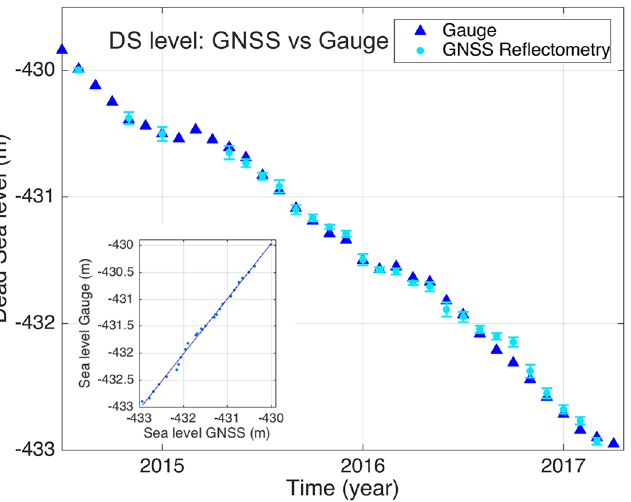
Figure 2. Blue triangles represent the DS lake level from 11th June 2014 to 29th March 2017, in meters below mean sea level, data provided by the Hydrological Service and Water Authority, Israel (Gauge near Massada). The DS lake level determined from GNSS reflectometry observations (Fig. 1, Beach stations) is shown in light blue (dots), with error bars. The standard error of the GNSS measurements is ± 2.7 cm. (Insert) The correlation coefficient between the two time series is 0.99, indicating the high accuracy of the GNSS observations.